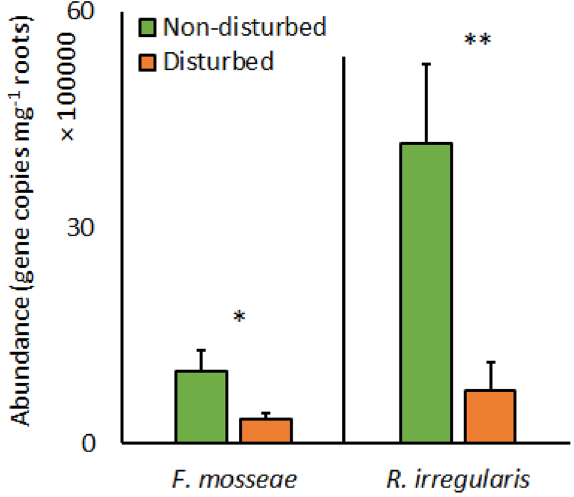
Figure 3. Abundance of arbuscular mycorrhizal fungal taxa in roots of the perennial plant species Crepis biennis either paired or not with weedy annual, Erigeron annuus , respectively, as affected by soil disturbance. Bars represent means accompanied by standard errors (n = 10).